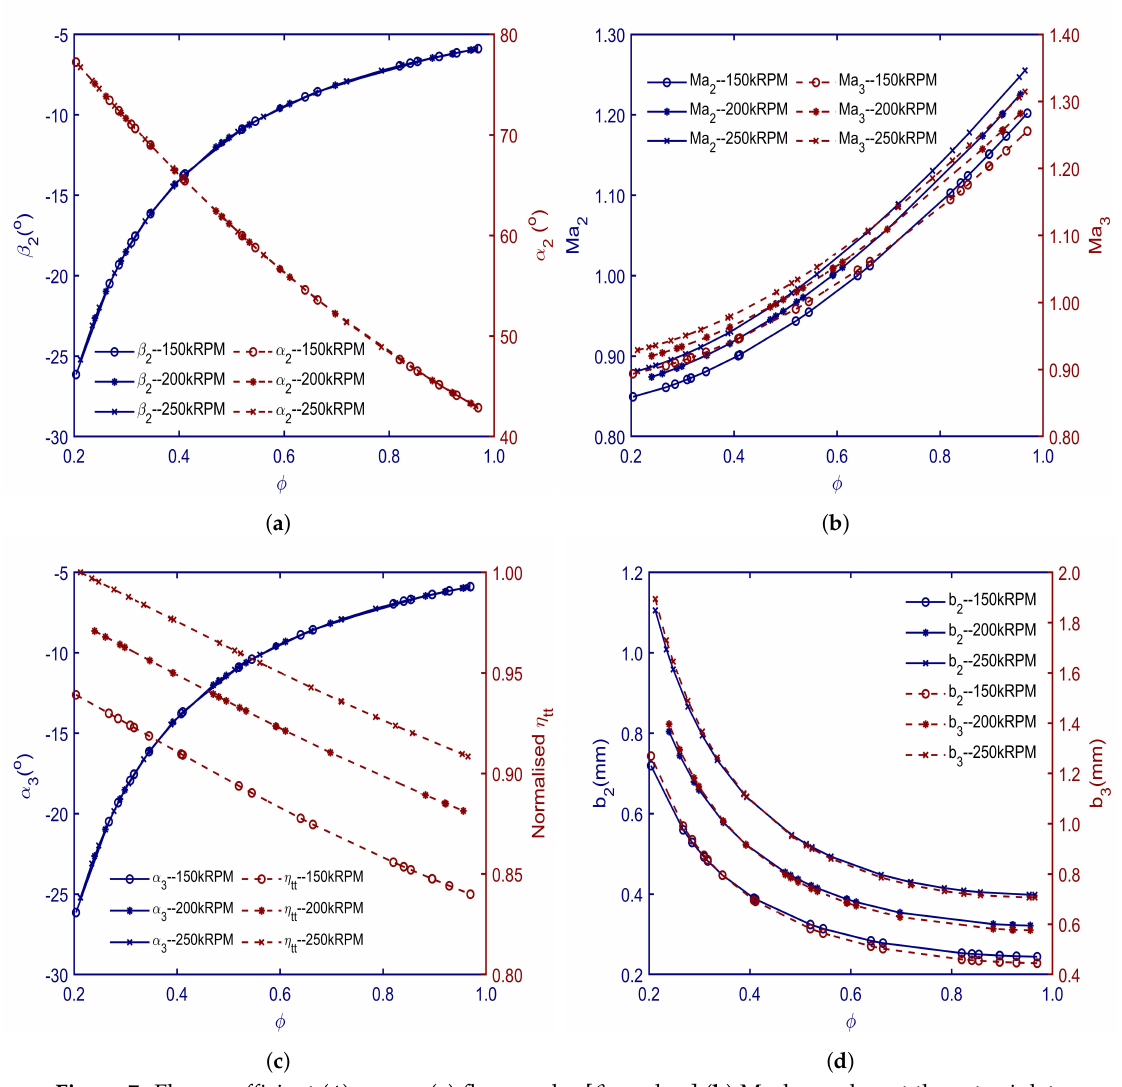
Figure 7. Flow coefficient ( φ ) versus ( a ) flow angles [ β 2 and α 2 ] ( b ) Mach number at the rotor inlet [Ma 2 ] and exit [Ma 3 ] ( c ) normalised efficiency [ η tt ] and swirl angle [ α 3 ] ( d ) blade heights [b 2 and b 3 ] at various rotational